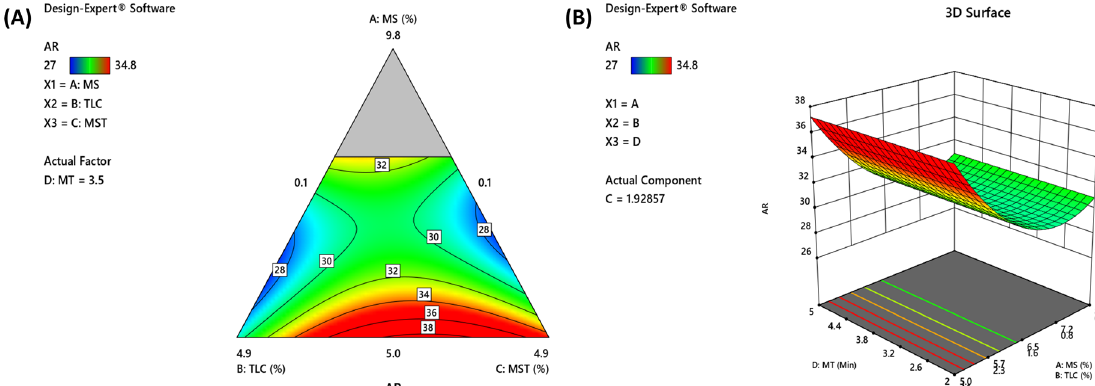
FIGURE 1 - (A) CONTOUR PLOT AND (B) 3D SURFACE PLOT FOR RESPONSE AR.